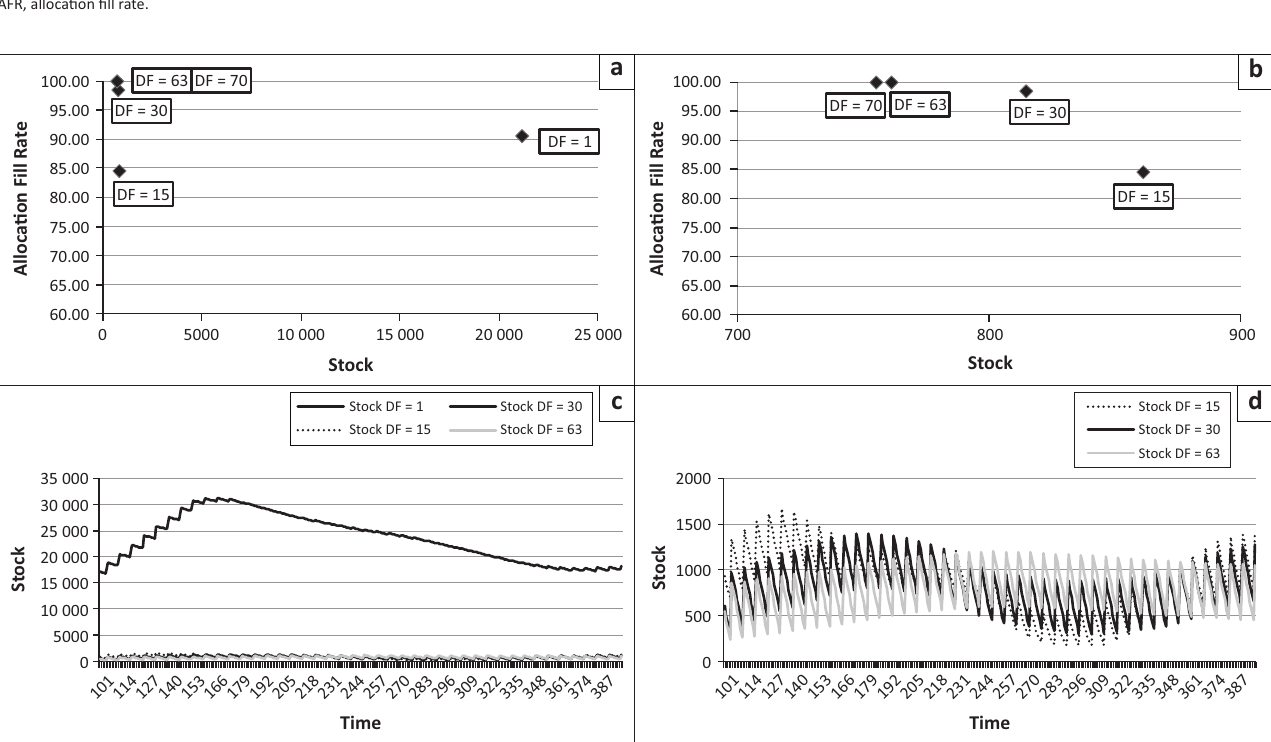
FIGURE 2: Impact of the damping factor on import supplier supply chain, where (a and c) damping factor is set to 1 for imported supplier parts and (b and d) removing damping factor equal to